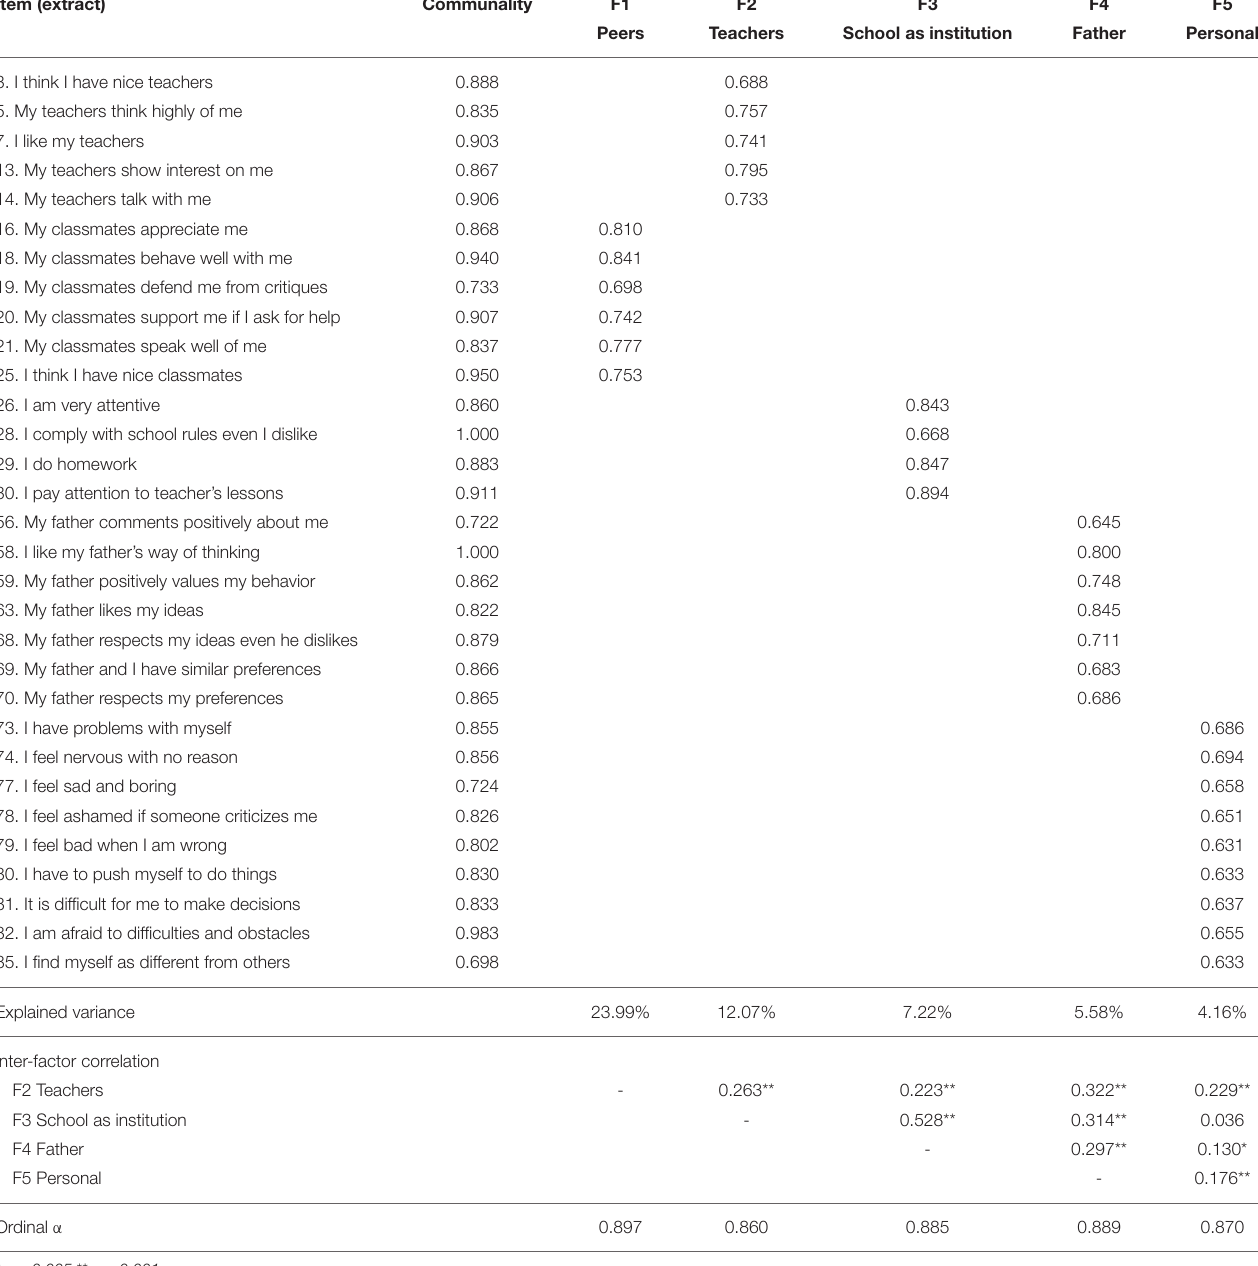
TABLE 2 | Summary of information about factors extracted from the EFA. Item